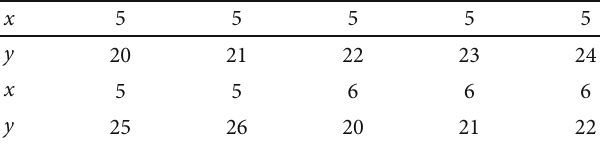
Table 3: Value sequence of x and y .